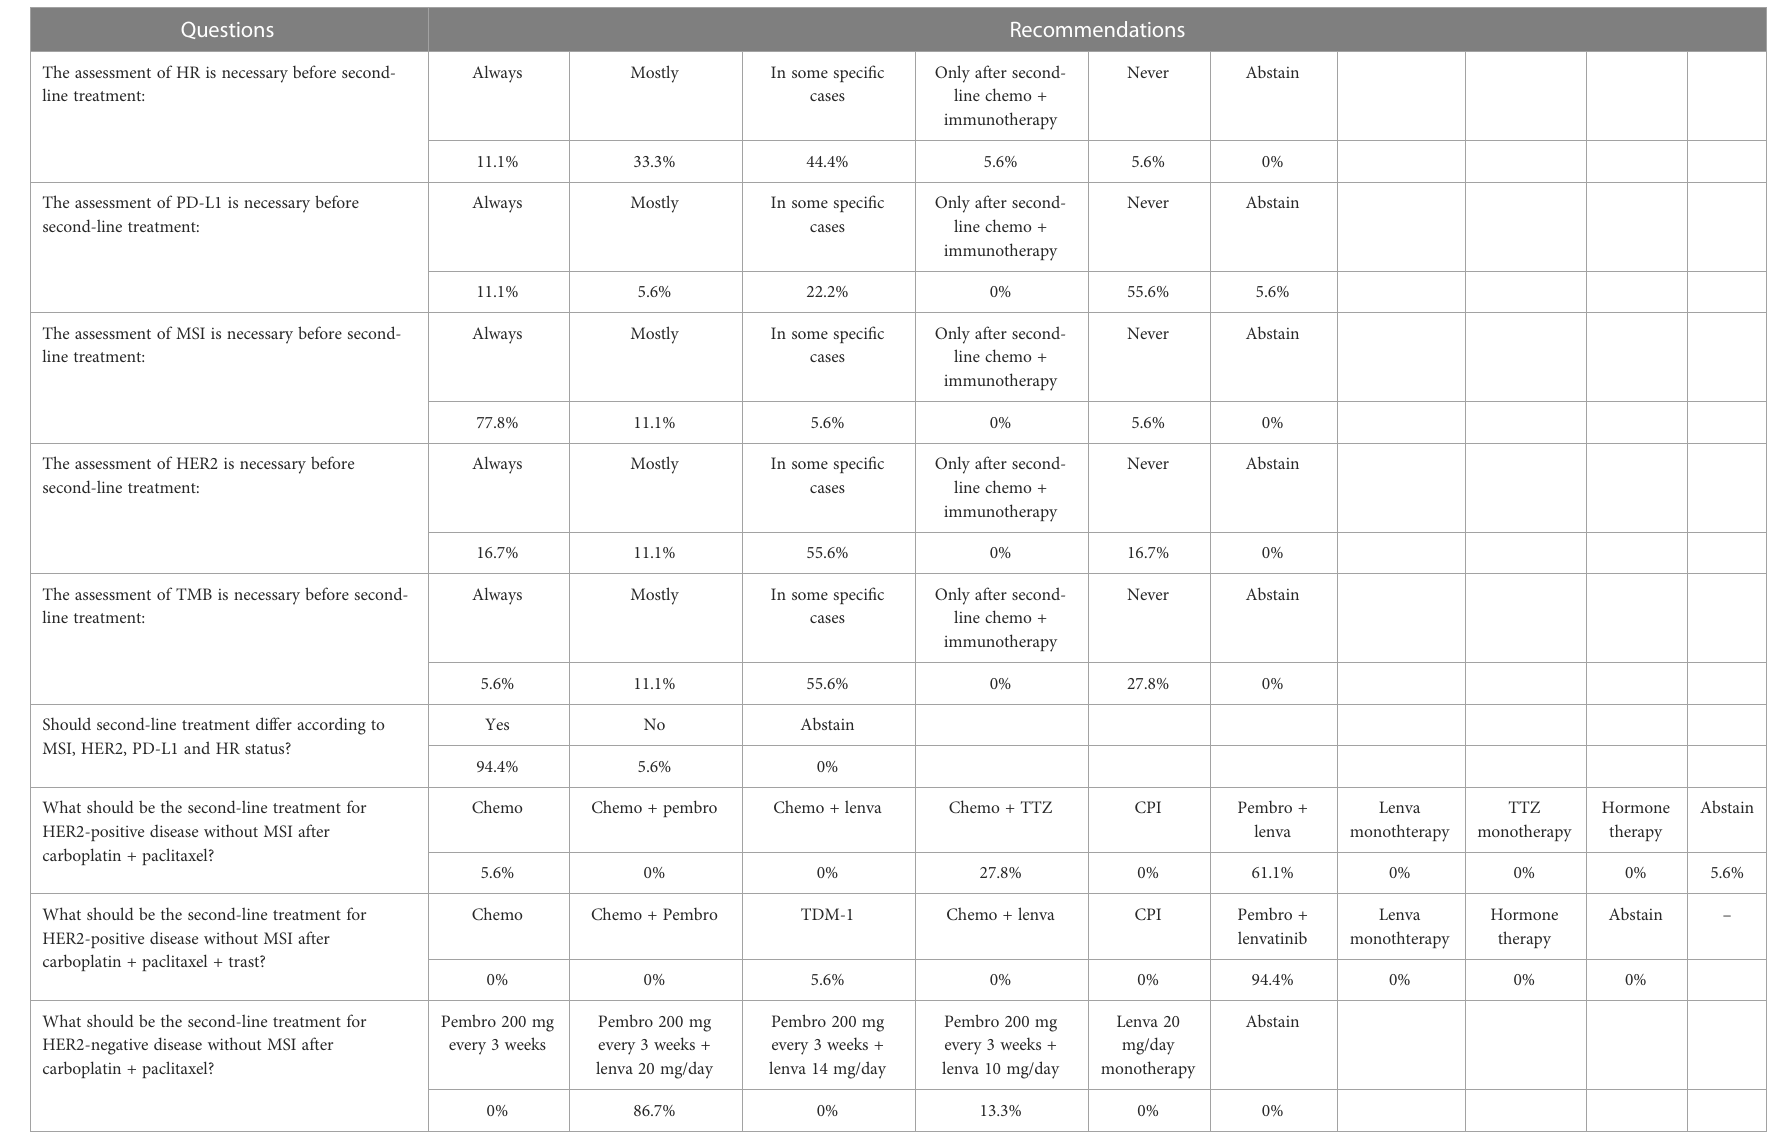
TABLE 3 Questions related to second-line